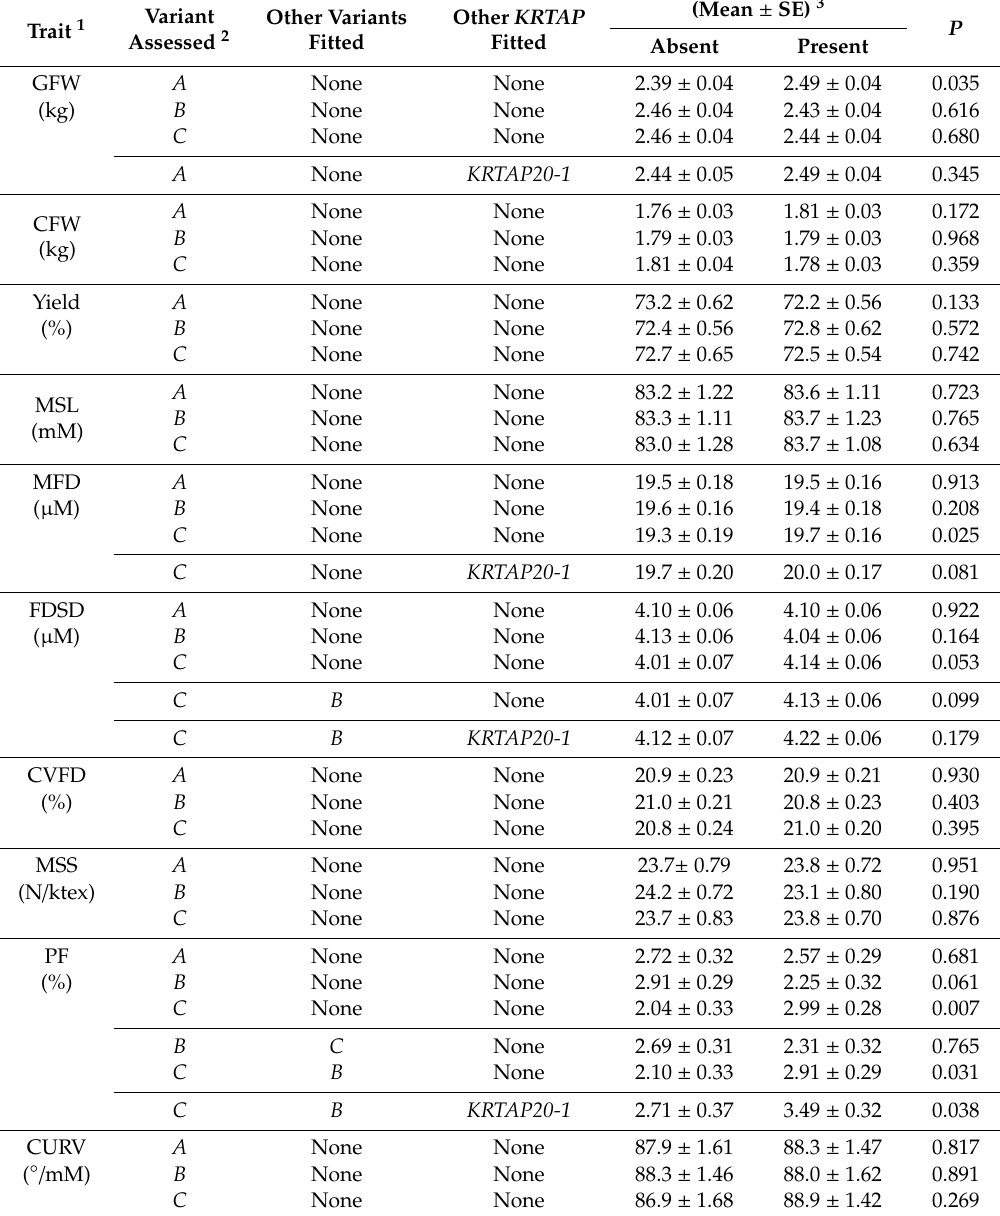
Table 1. Association between the absence or presence of KRTAP36-1 variants and various wool traits. Trait